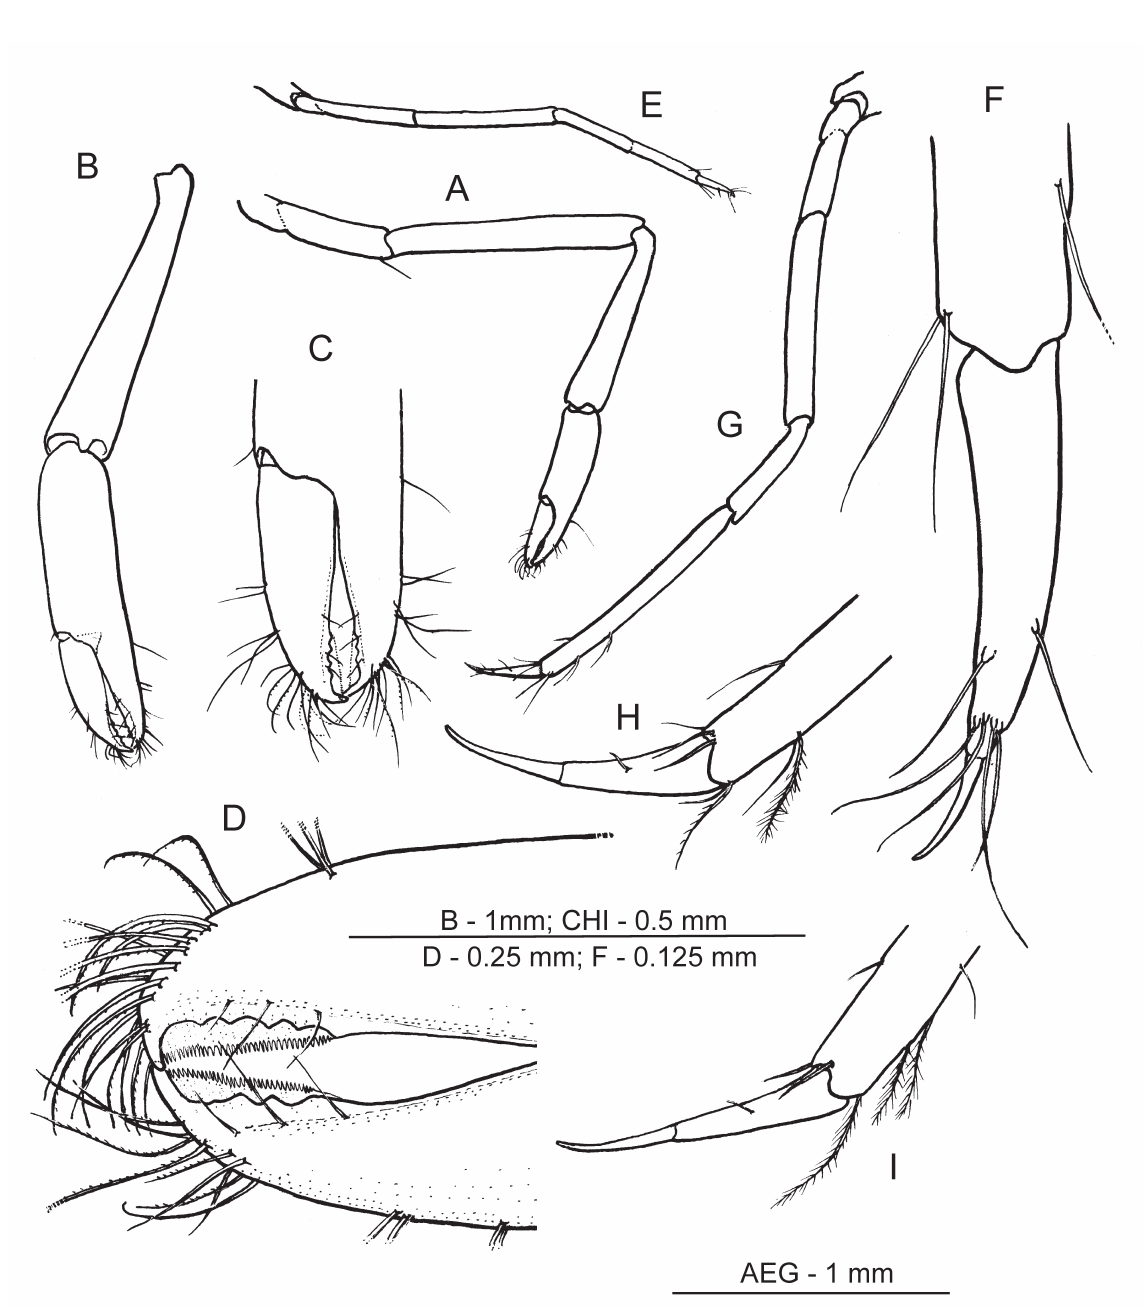
Fig. 3. Hamodactylus paraqabai sp. nov., ovigerous ♀ , holotype (PoCL 1.5 mm; Madang, Papua New Guinea ). A . Right first pereiopod. B . Same as previous, chela and carpus. C . Same as previous, fingers. D. Same as previous, detail of denticulations. E . Second pereiopod, lateral. F . Same as previous, dactylus and distal propodus. G . Third pereiopod. H . Same as previous, dactylus and distal propodus. I . Fifth pereiopod, dactylus and distal